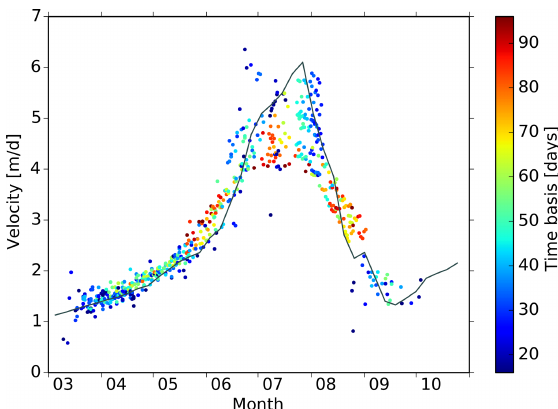
Figure A1. Landsat velocities at the terminus of Harald Moltke Bræ in the year 2017, colour scaled with the time basis. For comparison, the velocities from Sentinel-1 (P) are plotted as grey